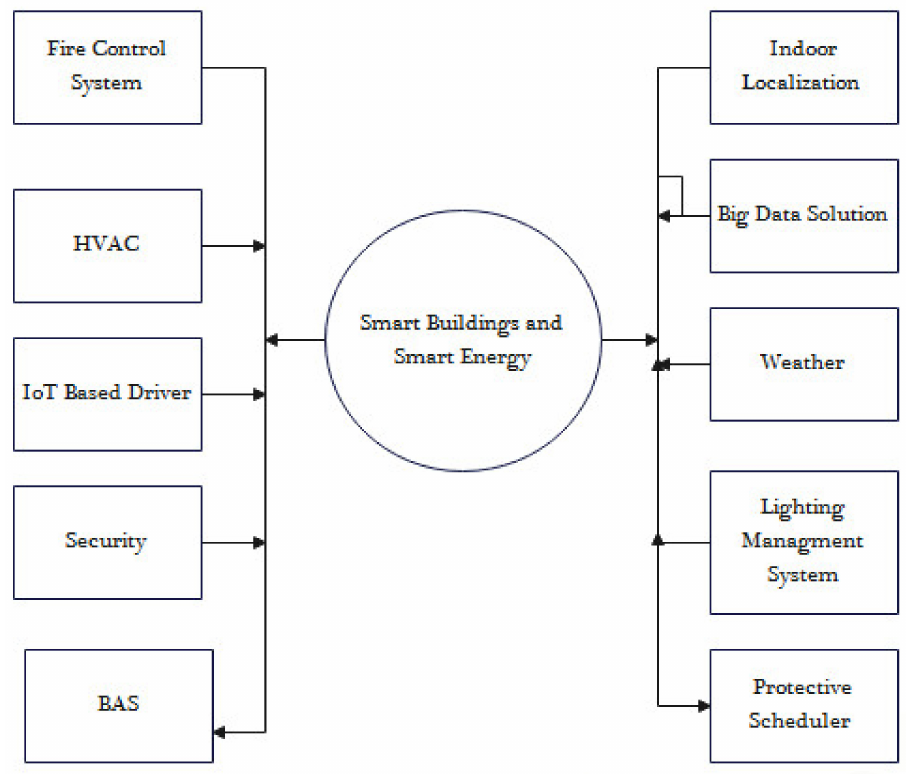
Figure 3. Architectural requirements to integrate pre-existing buildings with a smart